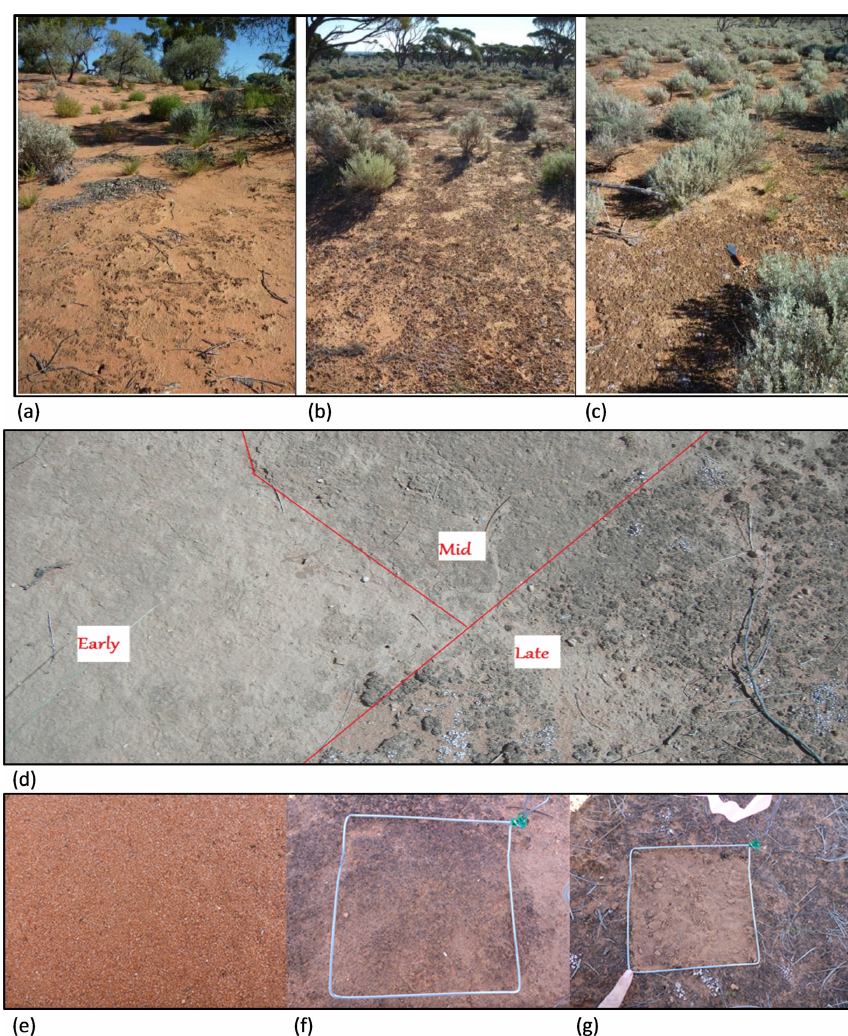
Figure 2. (a) SMU 1 (Sites 4, 9, and 10): type 1–3 biocrusts on deep calcareous yellow sands (dunes). (b) SMU 2 (Sites 1, 5, and 8): primarily type 4 and 5 biocrusts on shallow calcareous sandy loam. (c) SMU 3 (Sites 2, 3, and 7): type 1–5 biocrusts on deep calcareous sandy loam (photographs by Samantha Doudle, 2011). (d) Different biocrust stages (top) north of stockpile 19, adjacent to Site 9; (e) bare, (f) early, and (g) late stages, also showing biocrust sample already removed from the late stage (photographs by Angela